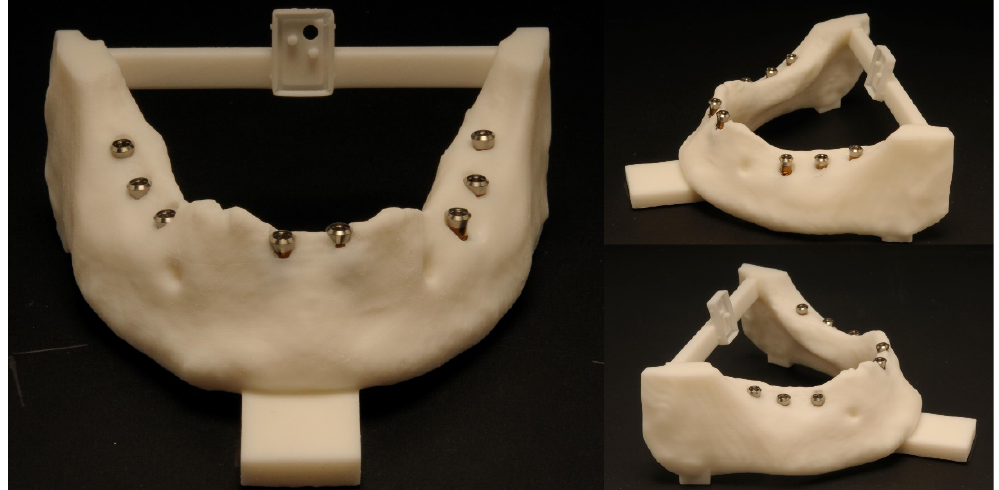
Figure 8. Illustrated are acrylic mandibles of three different young professionals on the second ses- sion. Considerably less problems were seen on the second session; most implants could be inserted in a satisfying position.